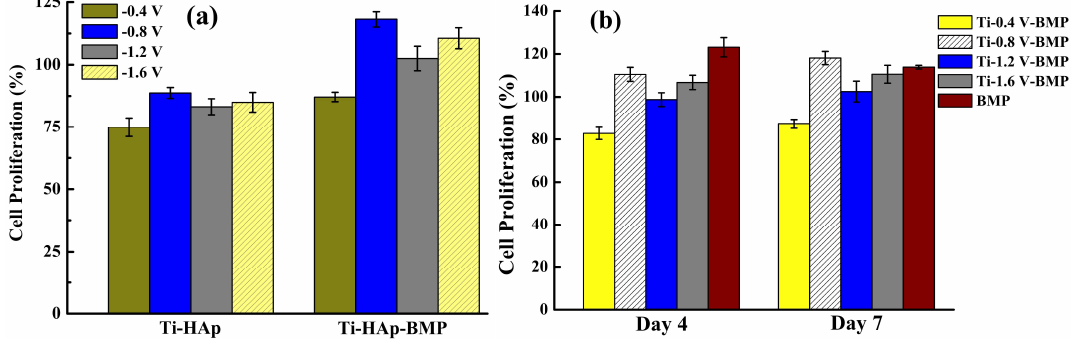
Figure 7. Cell proliferation sequential release of ( a ) Ti–HAp and Ti–HAp–BMP coprecipitation samples after 4 days; ( b ) samples under different ECD potential conditions after 4 and 7 days. The Ti-0.8 V BMP sample showed a better and continuously increasing cell proliferation rate for up to 7 days.